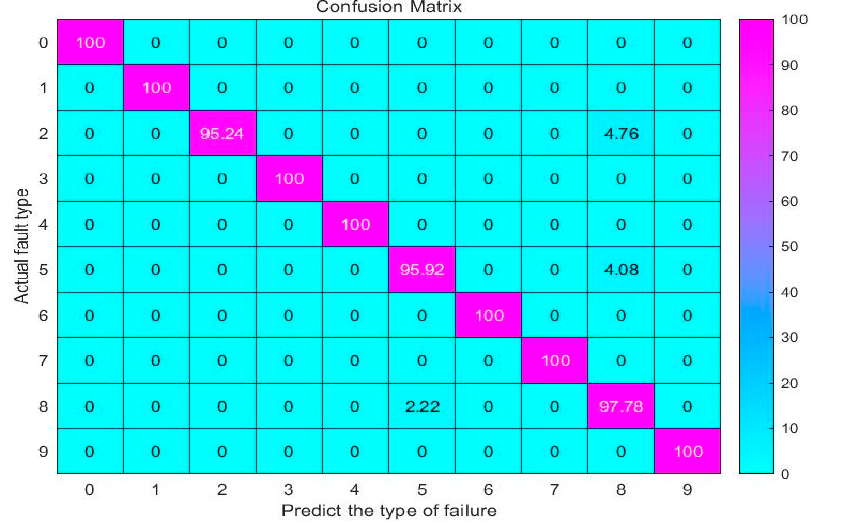
Figure 18. Variation in loss with iteration number.